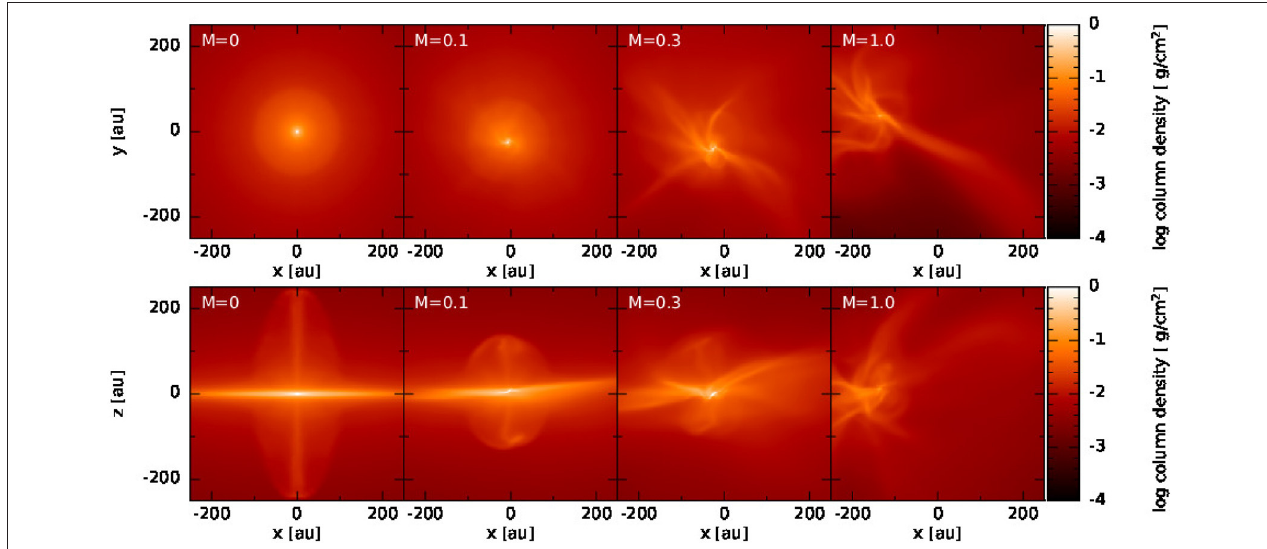
FIGURE 4 | The face-on (Top row) and edge-on (Bottom row) gas column density projections showing disc formation in models in a relatively strong ( µ 0 = 5) magnetic field with a turbulent velocity field imposed onto a solid-body rotation. The Mach number is shown in each panel. The figures are taken ∼ 500 yr after sink formation (i.e., when the maximum density has reached ρ max = 10 − 10 g cm − 3 ). Increasing turbulence in these models hinders disc formation. These are inspired by Figure 7 of Lewis and Bate (2018), but are from lower resolution